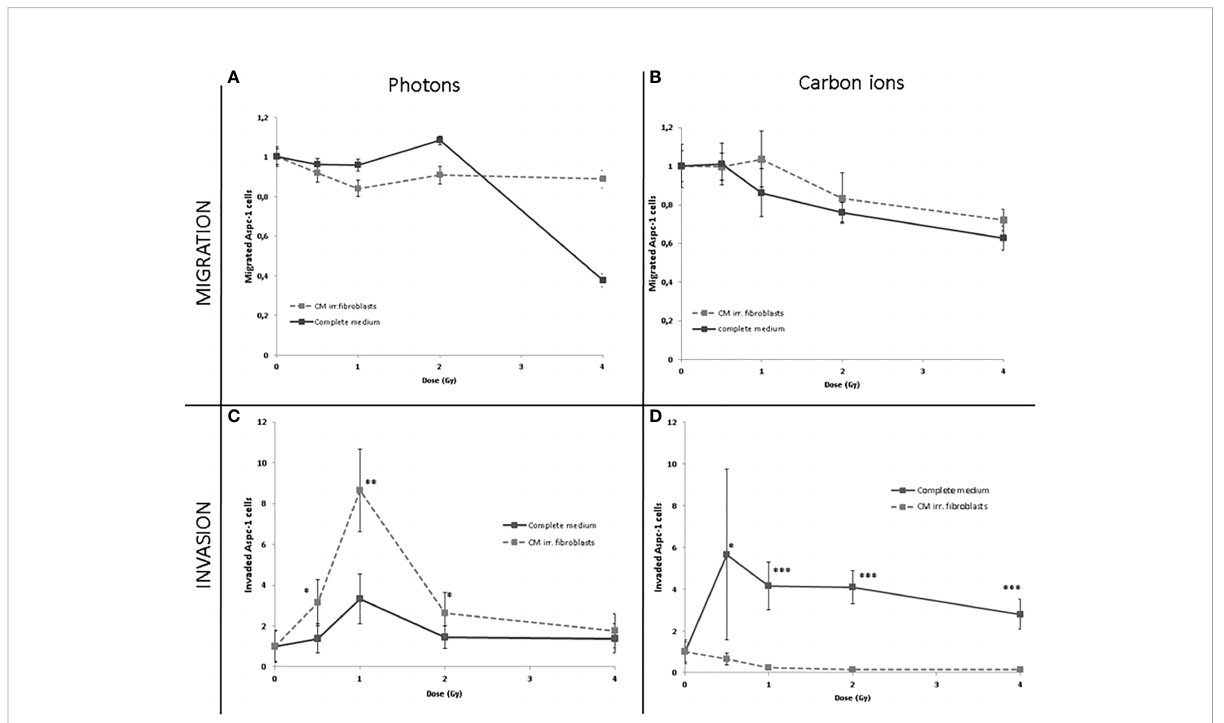
FIGURE 2 Migrated (A, B) or invaded (C, D) AsPC-1 cells photon (A, C) or C-ion (B, D) irradiated toward complete fresh medium collected from irradiated normal fi broblasts. Data are normalized to control condition and are presented as mean ± SDs of triplicate experiments. * statistically signi fi